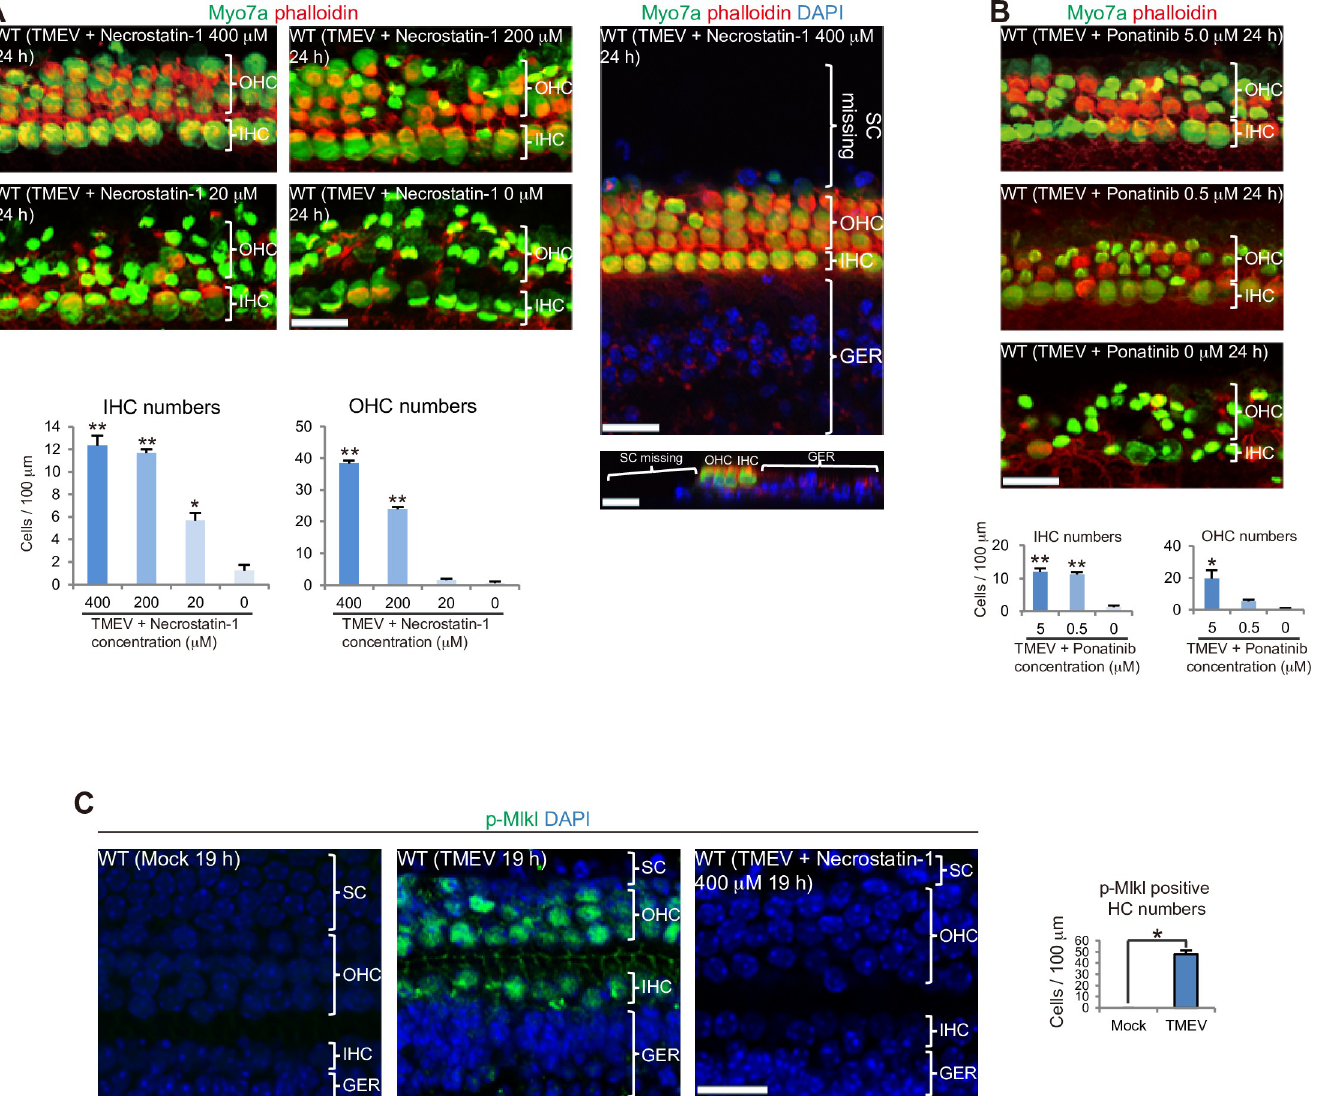
Fig 4. Necroptosis inhibitors supress HC damage. ( A, B ) Necroptosis inhibitors necrostatin-1 ( A ) (IHC and OHC: P < 0.0001, ANOVA, 400 μ M: n = 3, 200 μ M: n = 3, 20 μ M: n = 3, 0 μ M: n = 4) and ponatinib ( B ) (IHC: P < 0.0001, OHC: P = 0.0021, ANOVA, 5 μ M: n = 3, 0.5 μ M: n = 4, 0 μ M: n = 4) both attenuated HC death ( � P < 0.001, �� P < 0.0001, Bonferroni). While HCs were protected by Necrostatin-1 during TMEV infection, the death of SCs was not diminished, demonstrating that Necrostatin-1 functions directly to HCs as well as the TRAIL-neutralizing antibody. ( C ) p-Mlkl (green) expression in HCs induced by TMEV infection was inhibited